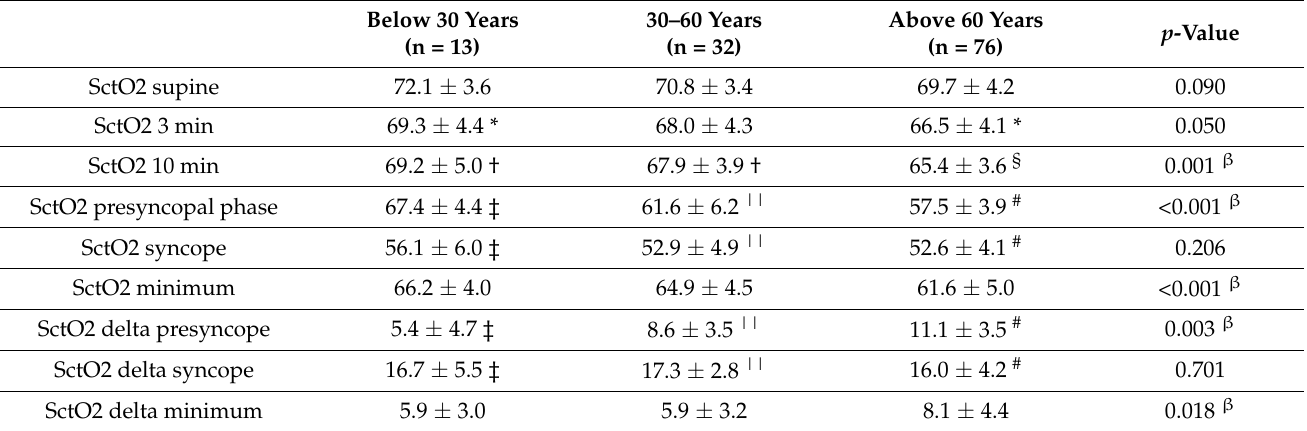
Table 3. Cerebral tissue oxygenation according to age in OH patients during head-up tilt